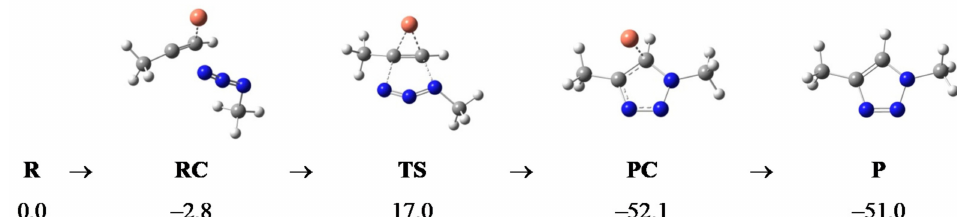
Figure 4. Cu(I)-catalyzed conversion of alkyne m1 0 and azide m2 into triazole with Cu(I) bound to alkyne. Relative Gibbs free energies for isolated reactants ( R ), reactant complex ( RC ), transition state ( TS ), product complex ( PC ) and isolated product ( P ) correspond to the DMF solution (in kcal mol − 1